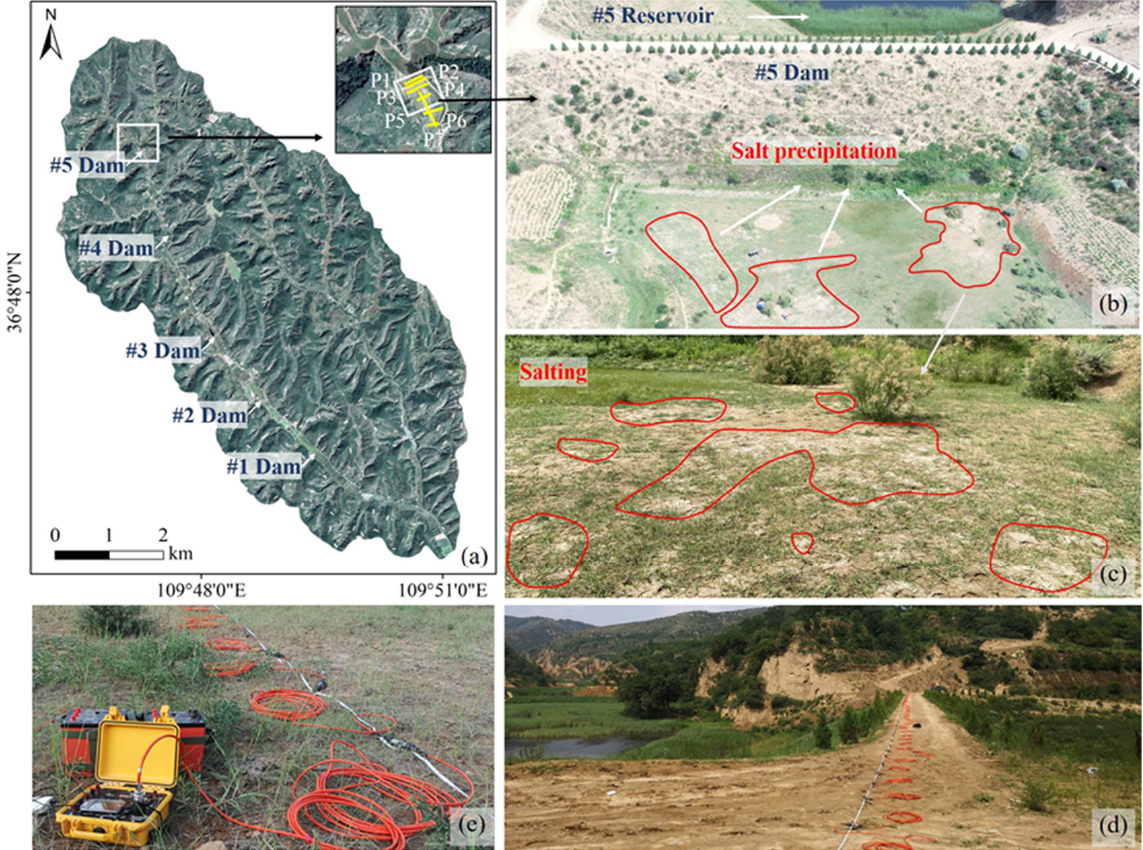
Figure 5. Layout of ERT profiles and field photos. ( a ) Remote sensing image map of the GTW showing the location of the five dams and the ERT profile; ( b ) site map of the #5 reservoir and #5 dam, with salinized arable land downstream of the dam; ( c ) local photo of salt precipitate on farmland located downstream of the #5 dam; ( d ) site photo of the P2 profile; ( e ) ERT fieldwork photo.